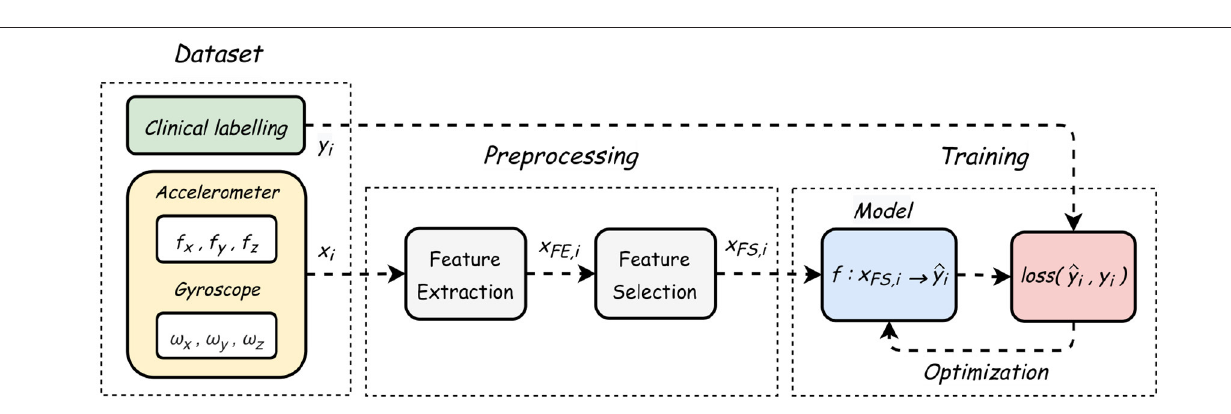
FIGURE 3 | Flowchart diagram showing the process from data collection to model